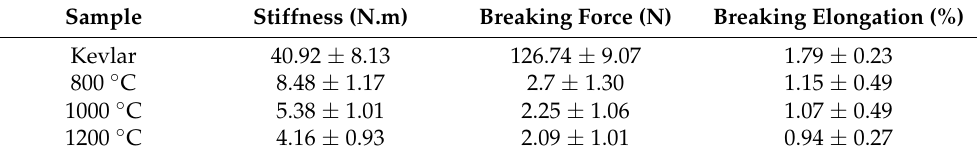
Table 2. Effect of carbonization temperature on mechanical properties of activated carbon fabric. Sample